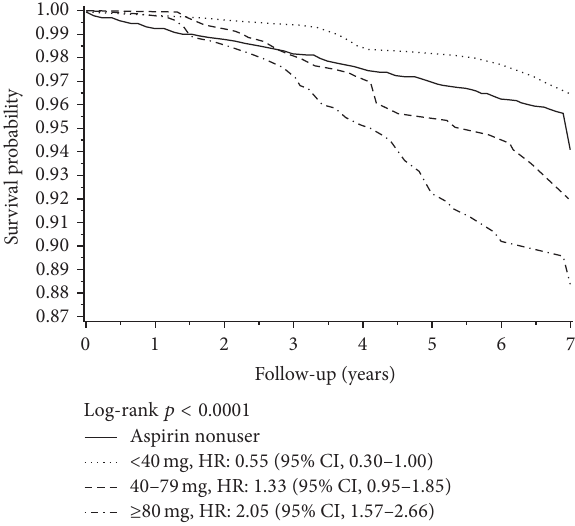
Figure 2: All-cause dementia-free survival curves by mean daily dosage of